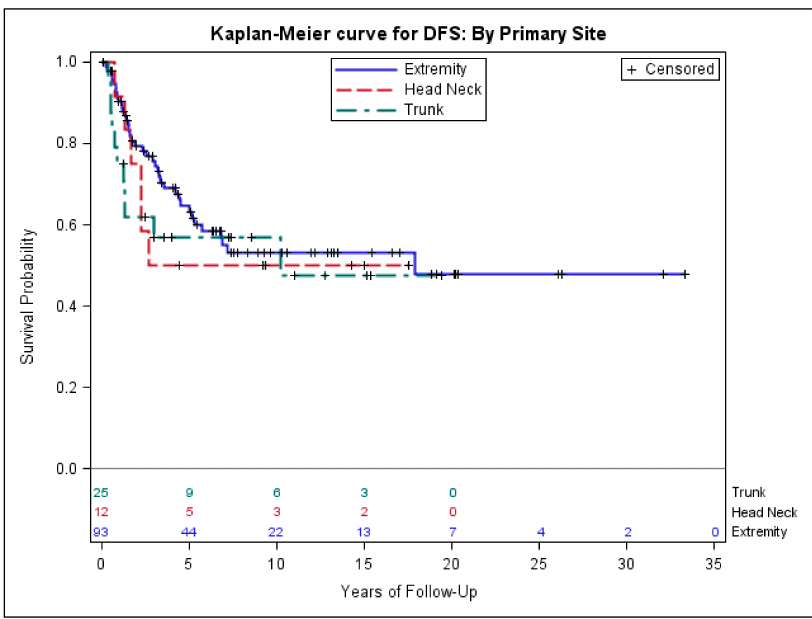
Figure 3. Kaplan–Meier estimates of disease-free survival of early-stage patients with extremity, head and neck, and trunk primary site.